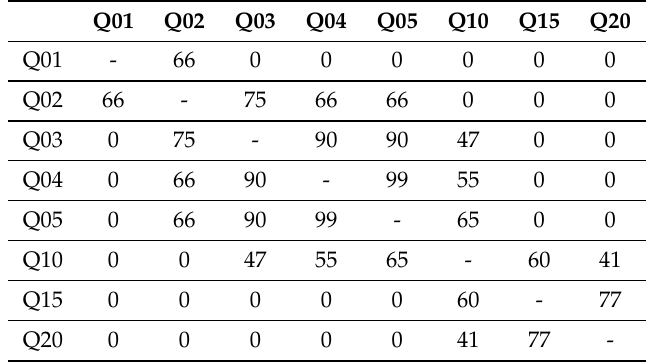
Table 7. Test results for similar plain text files with ssdeep.